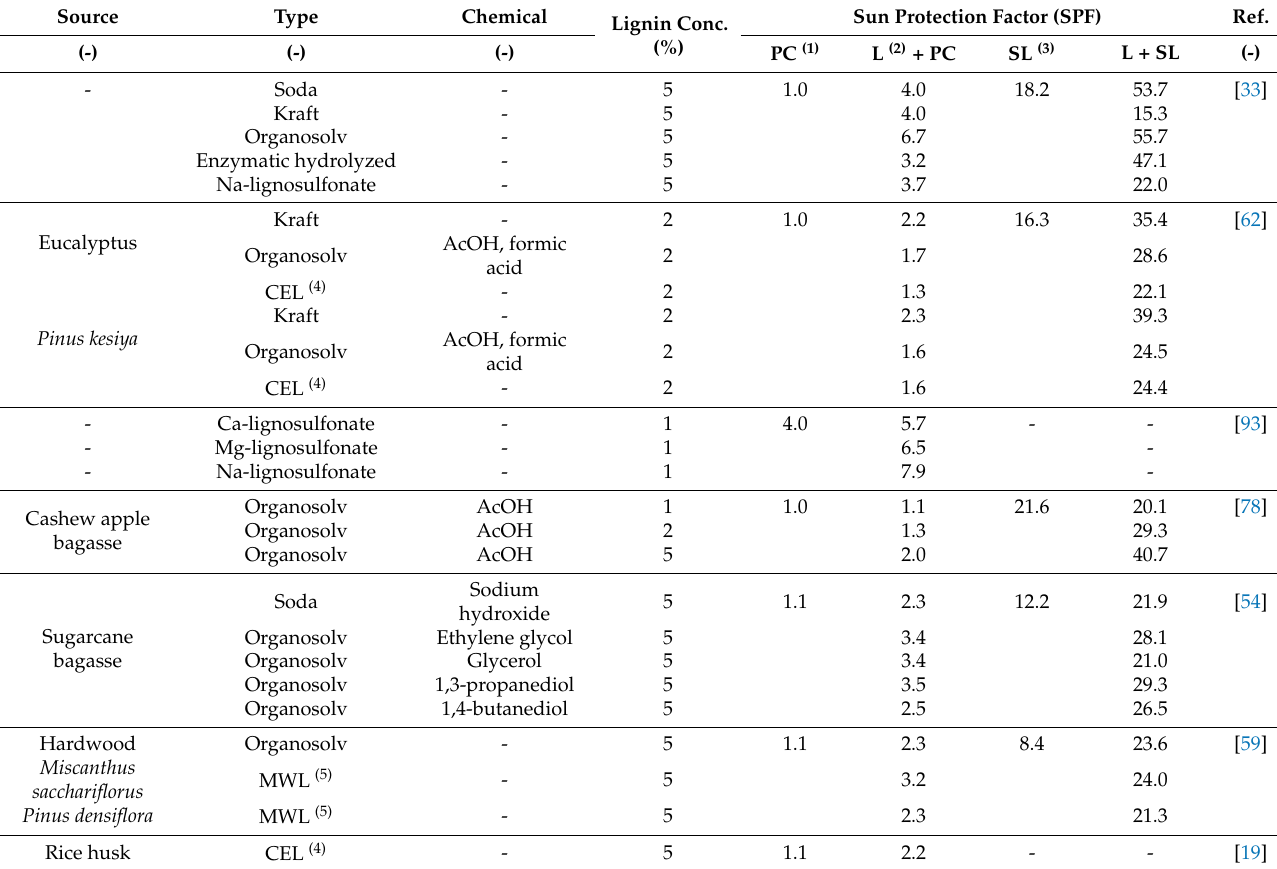
Table 5. Sun protection factors of lignin prepared from various type of